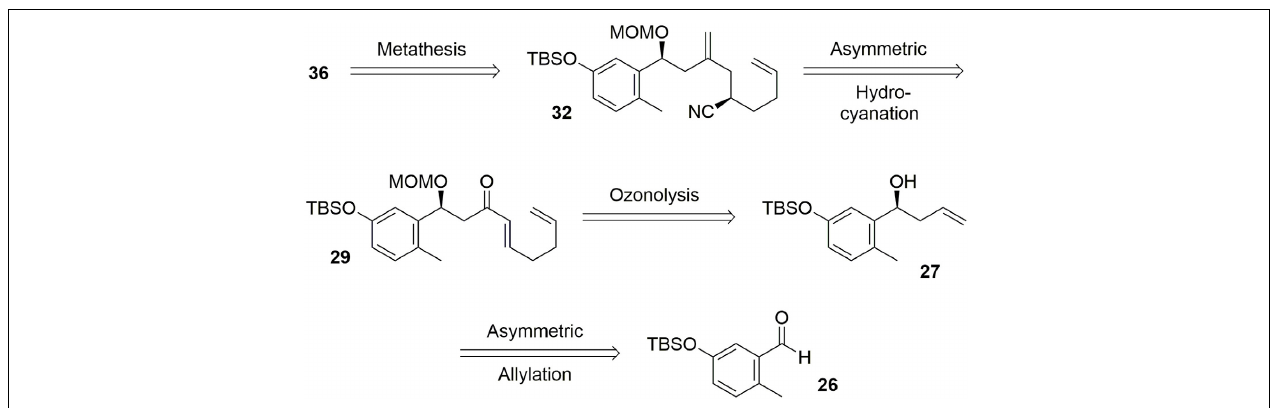
FIGURE 6 | Kaurane main core retrosynthesis.